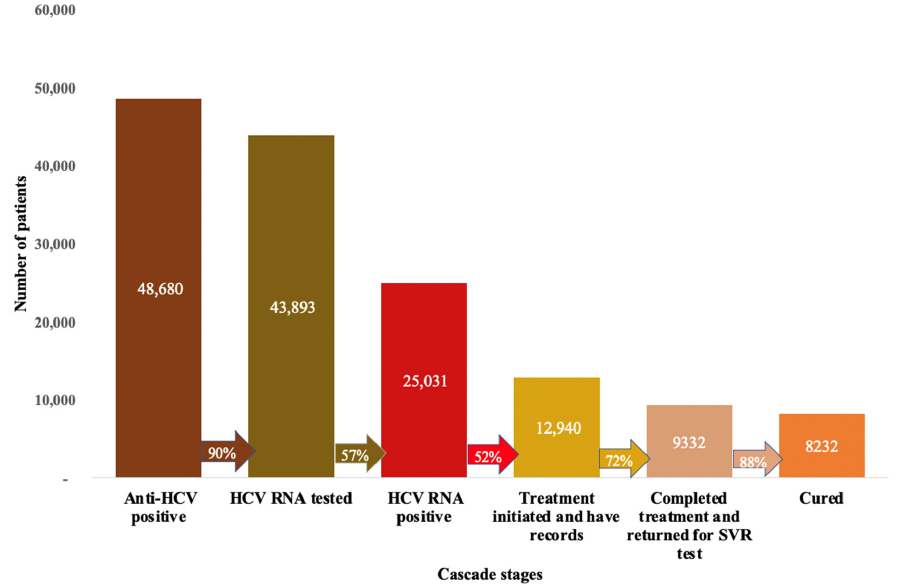
Figure 2. HCV cascade of care in Rwanda for the 2017–2019 mass screening and treatment campaign cohort.